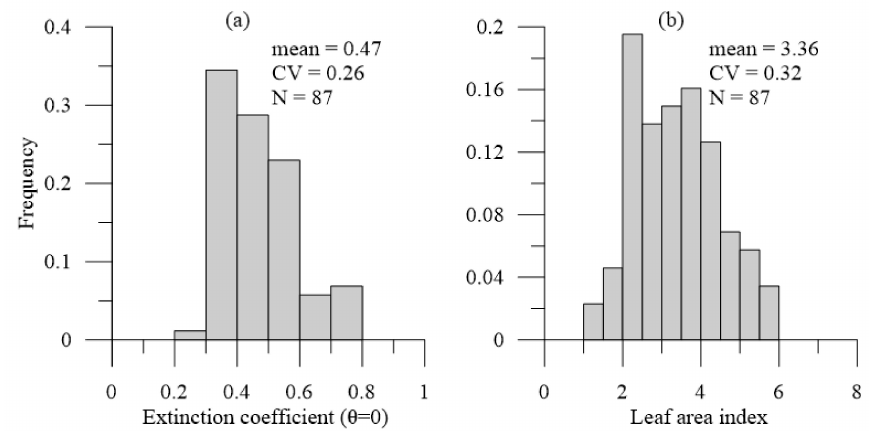
Figure 8. Statistics for the retrieved extinction coe ffi cient ( a ) and leaf area index ( b